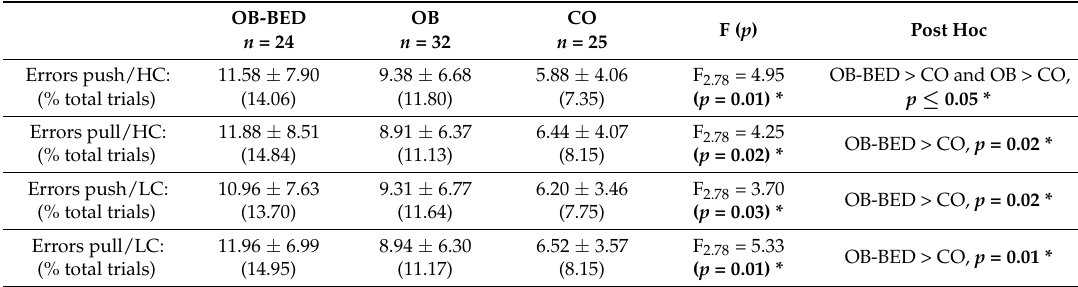
Table 4. Comparisons (MANOVA) between OB-BED, OB, and CO with regard to errors per condition (push/pull and HC/LC) x group. Error frequencies in % are shown in brackets. OB-BED = patients with obesity and current BED, OB = subjects with obesity without BED, CO = norm-weight controls without self-reported lifetime eating disorder diagnosis. HC = high-calorie food picture, LC = low-calorie food picture. OB-BED n =